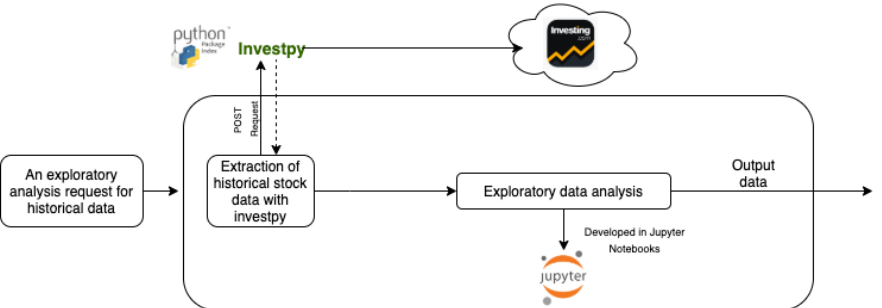
Figure 5. Data Analysis Package Design